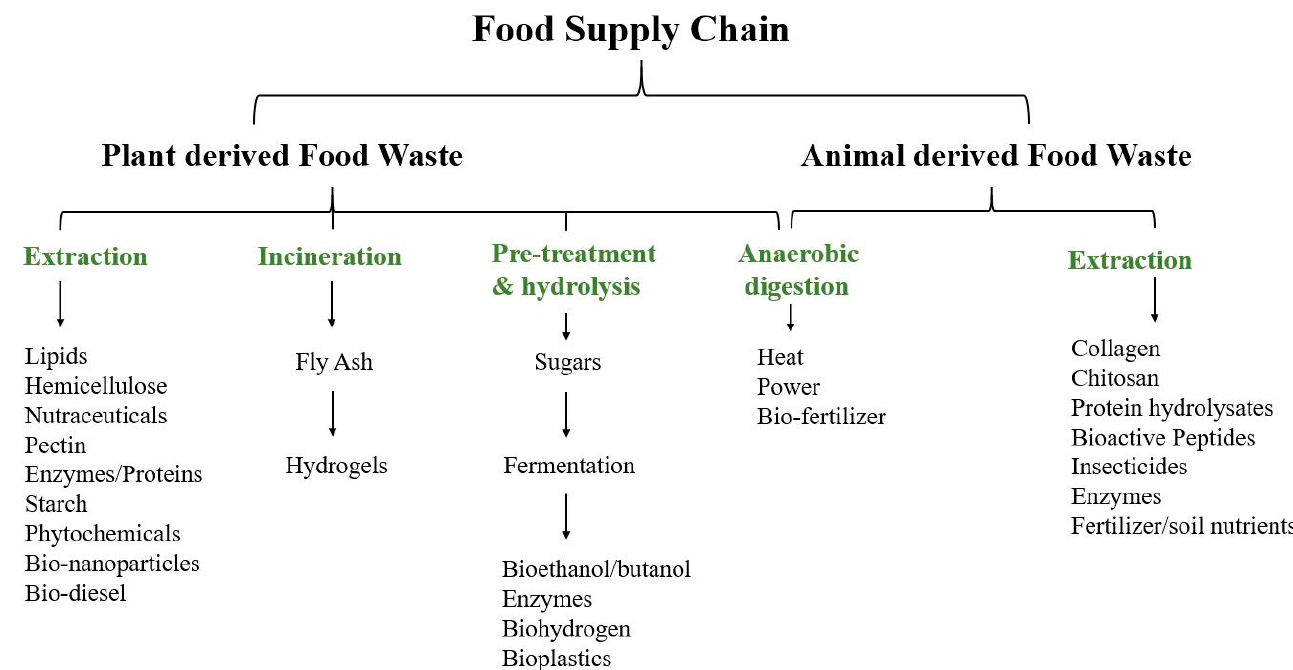
Figure 1. Possible new bioactive compounds extracted from agro-food waste.